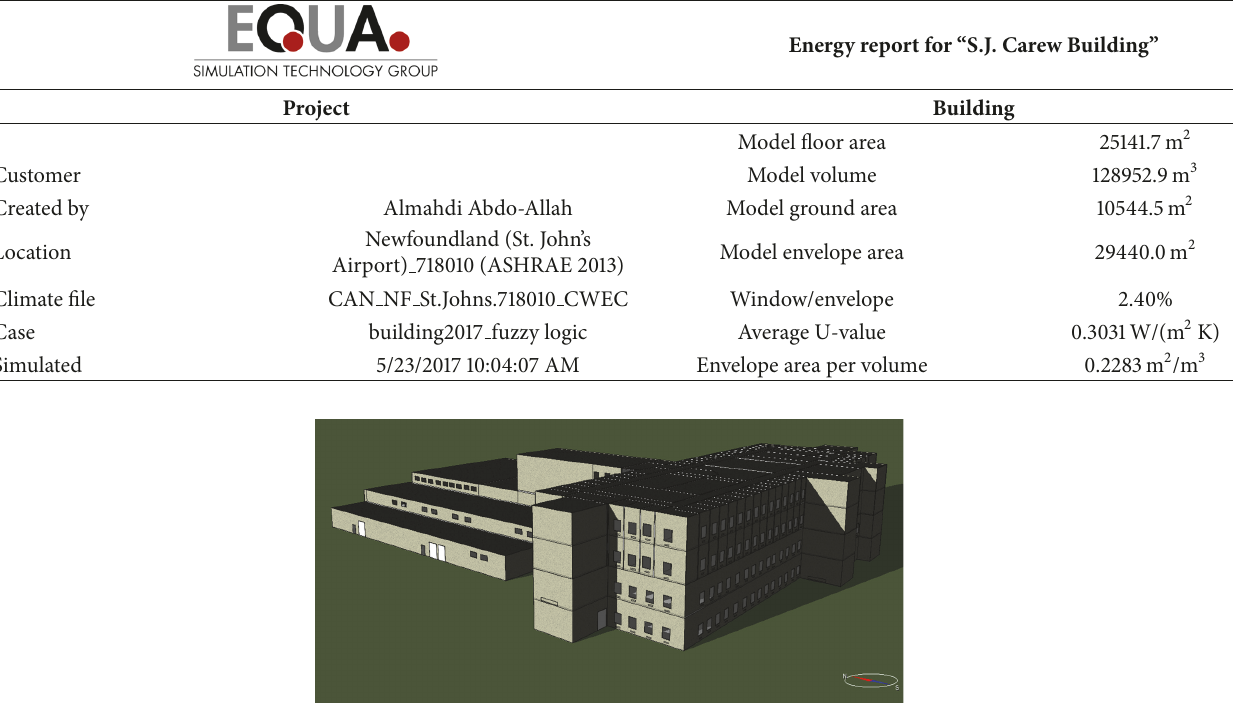
Table 1: Energy report for the building.